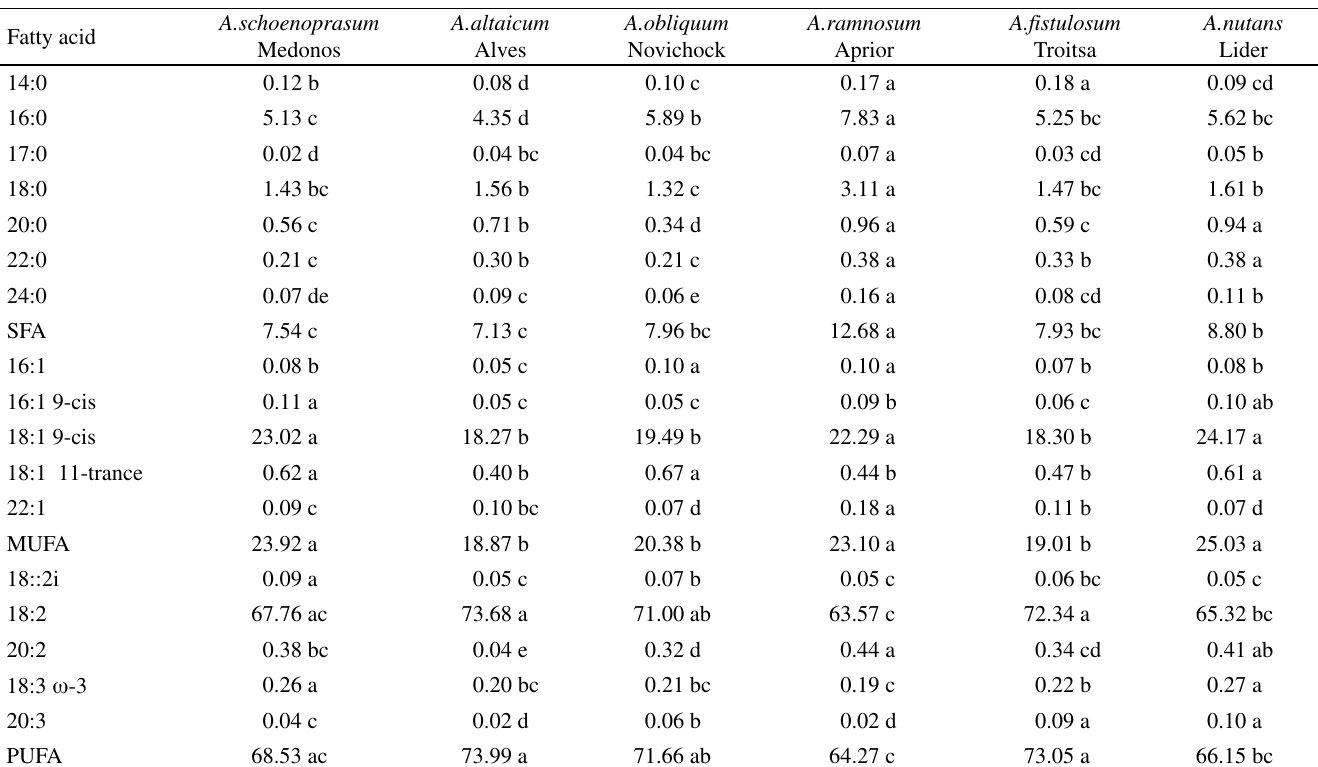
Along each row, means followed by different letters are significantly different according to the Duncan test at p≤0.05 (n=3). SFA= saturated fatty acids; MUFA = mono unsaturated fatty acids; PUFA = poly unsaturated fatty acids.